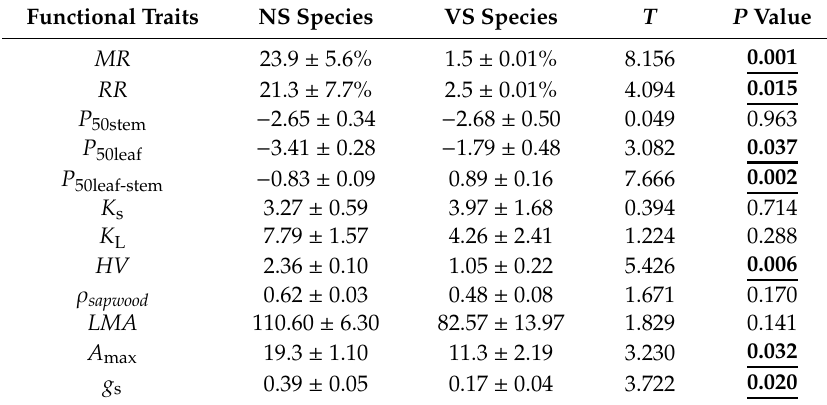
Table 2. Comparison of the mortality rate, recruitment rate, hydraulic, and photosynthetic traits between NS species and VS species. The abbreviations of the functional traits are shown in Table 1. Significant di ff erences between the NS species and VS species relationships are shown in bold and underlined.